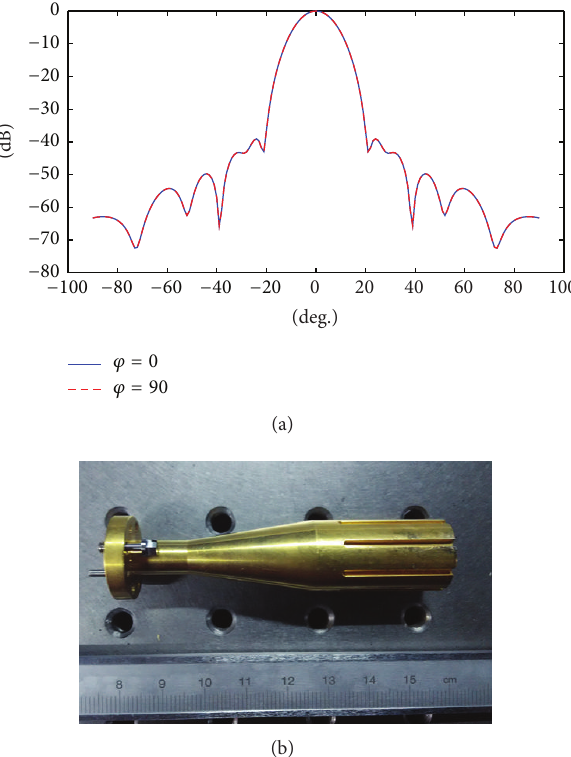
Figure 9: 183 GHz corrugated horn: (a) predicted far field pattern; (b) fabricated